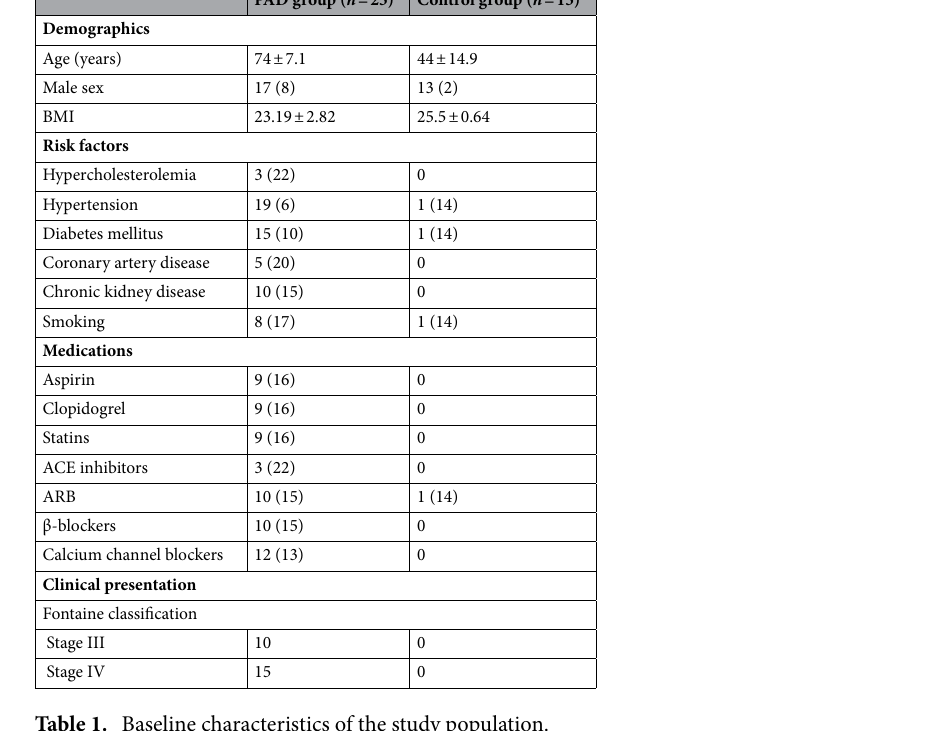
Table 1. Baseline characteristics of the study